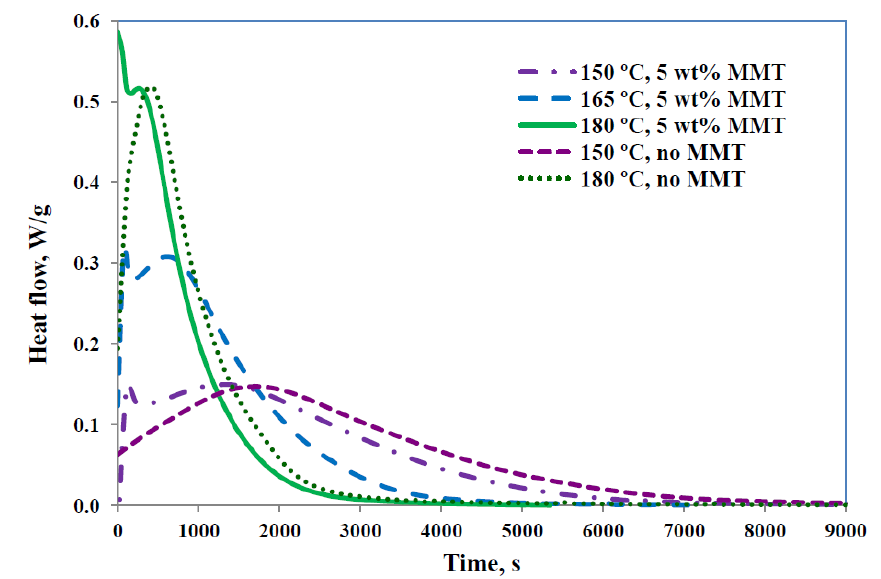
Figure 2. Isothermal cure of TGAP/MMT/DDS system: samples containing 5 wt% MMT at the temperatures of 150 °C (light purple, dash-dotted), 165 °C (blue, long dash), and 180 °C (light green, full); samples without MMT at the temperatures of 150 °C (dark purple, short dash) and 180 °C (dark green, dotted). Exothermic direction is